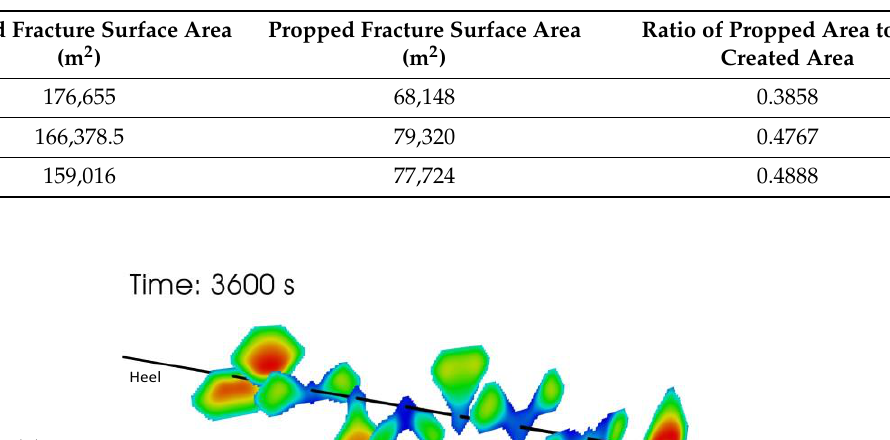
Table 6. Created/propped fracture area in cases using different fracturing fluids.